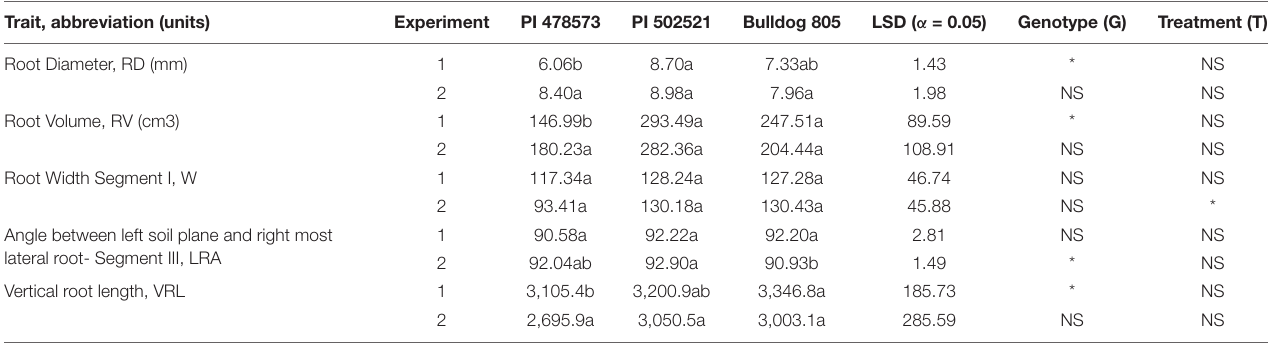
TABLE 3 | Phenotypic characterization of root traits in the alfalfa PI478573, PI502521, and Bulldog805 evaluated under water-stressed conditions in Exp. 1 and Exp. 2 evaluated using PVC mesocosms. Trait, abbreviation